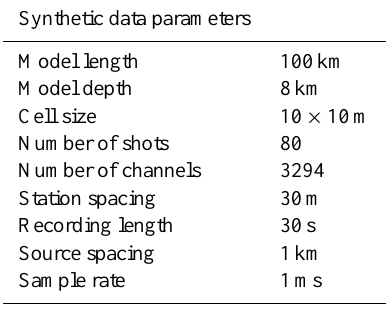
Table 2. Parameters used to generate synthetic data.